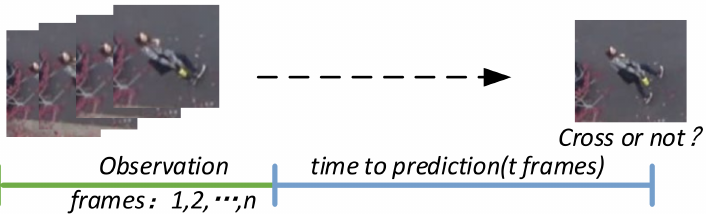
Figure 2. Pedestrian crossing behavior prediction task. N-frame observation is used to predict whether pedestrians cross the street after t frames.